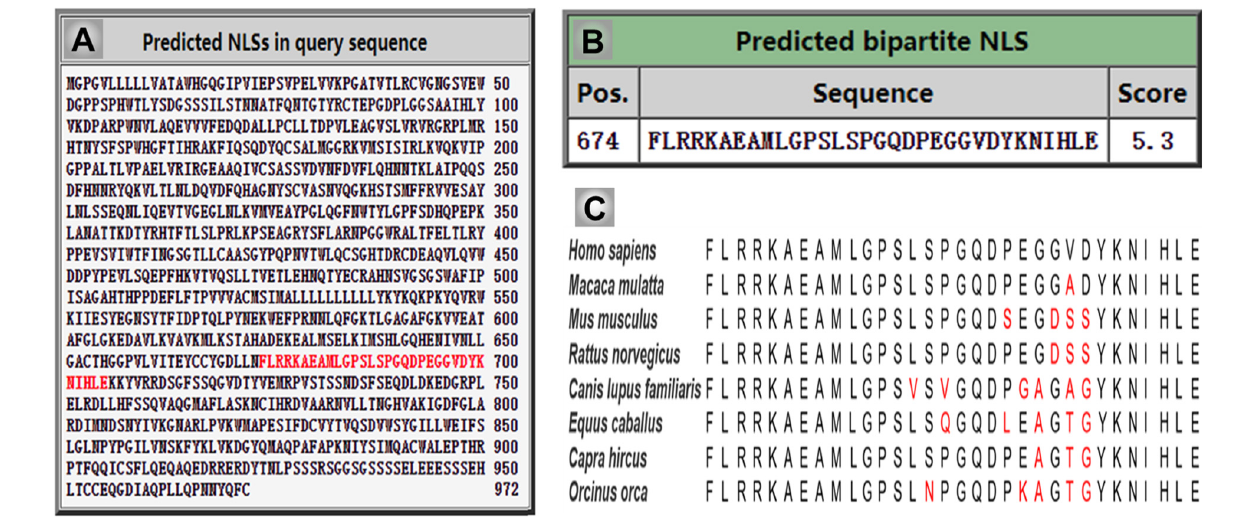
FIGURE 4 | The intercellular domain of CSF1R (CICD) contains nuclear localization signal (NLS), which is highly conserved in vertebrates. (A) The NLS sequence of human CSF1R is predicated and indicated in red using cNLS Mapper. (B) The score of human CSF1R NLS sequence is 5.3, which indicates the high possibility of its role in translocating CICD into the nucleus. (C) Homologous comparison of the NLS sequence of CSF1R in different vertebrate